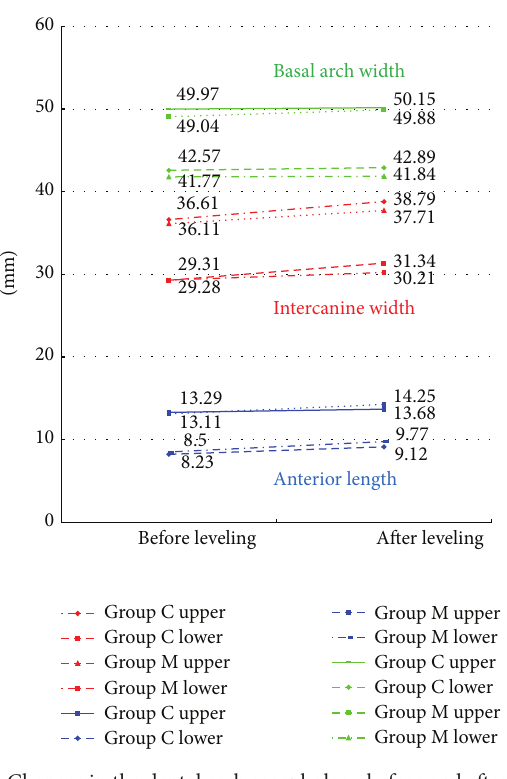
Figure 5: Changes in the dental arch morphology before and after leveling.